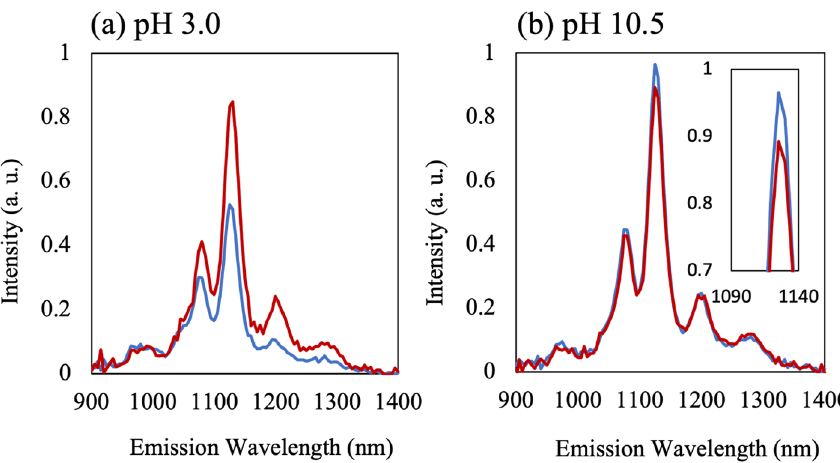
Figure 4. NIR-PL Spectra at ( a ) pH 3.0 and ( b ) 10.5. The blue and red spectra refer to that before and after the injection of the papain solution,